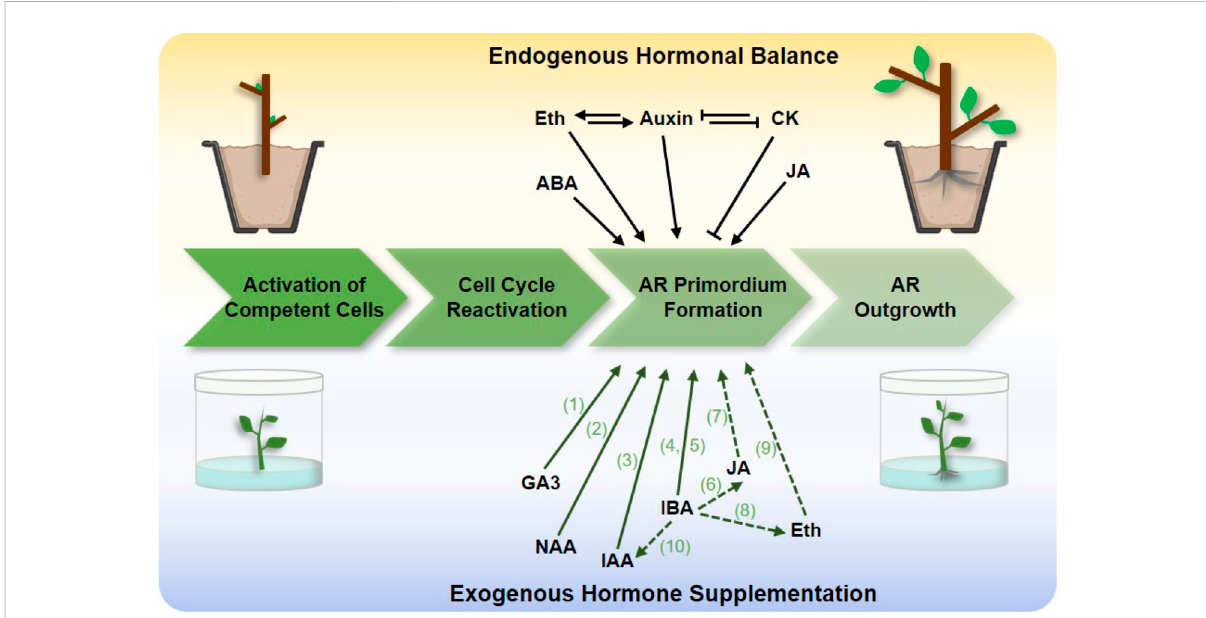
FIGURE 1 Hormones affecting adventitious root (AR) formation in clonal propagation by cuttings and tissue culture of a woody plant. The top panel is endogenous factors that directly induce AR primordium formation, the lower panel represents the effects of exogenous hormone supplementation for rooting. The phytohormones include jasmonic acid (JA), ethylene (Eth), cytokinins (CKs), abscisic acid (ABA), indole-3-butyric acid (IBA), indole acetic acid (IAA), 1-naphthalene acetic acid (NAA), gibberellin 3 (GA3). The dash lines represent the endogenous hormone response to exogenoushormoneapplication.Green lettersrepresentreferences 1 – 10:1)Fordetal.(2002);2)deAlmeidaetal. (2015);3)deAlmeidaetal.(2015); 4) Fett-Neto et al. (2001); 5) Harfouche et al. (2007); 6) Liu et al. (2021); 7) Liu et al. (2021); 8) Bai et al. (2020); 9) Kilkenny et al. (2012); 10) Munir et al. (2021). The arrows and “ T ” at the end of lines represent positive and negative regulation,